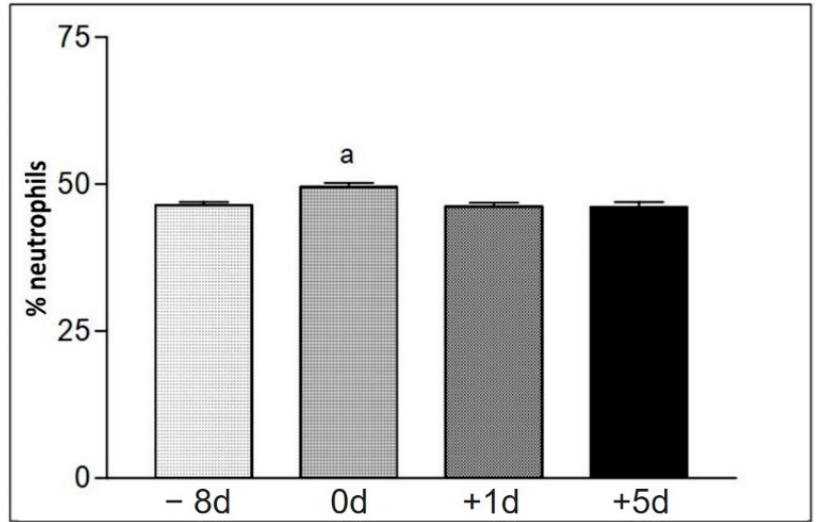
Figure 7. Representation of the average values referring to the counting of the relative number (%) of neutrophils (No) at the different collection days defined as − 8 d, 0 d, +1 d, and +5 d. Statistical difference according to the Tukey–Kramer test—Beltsville, 2003. a = significant statics difference.